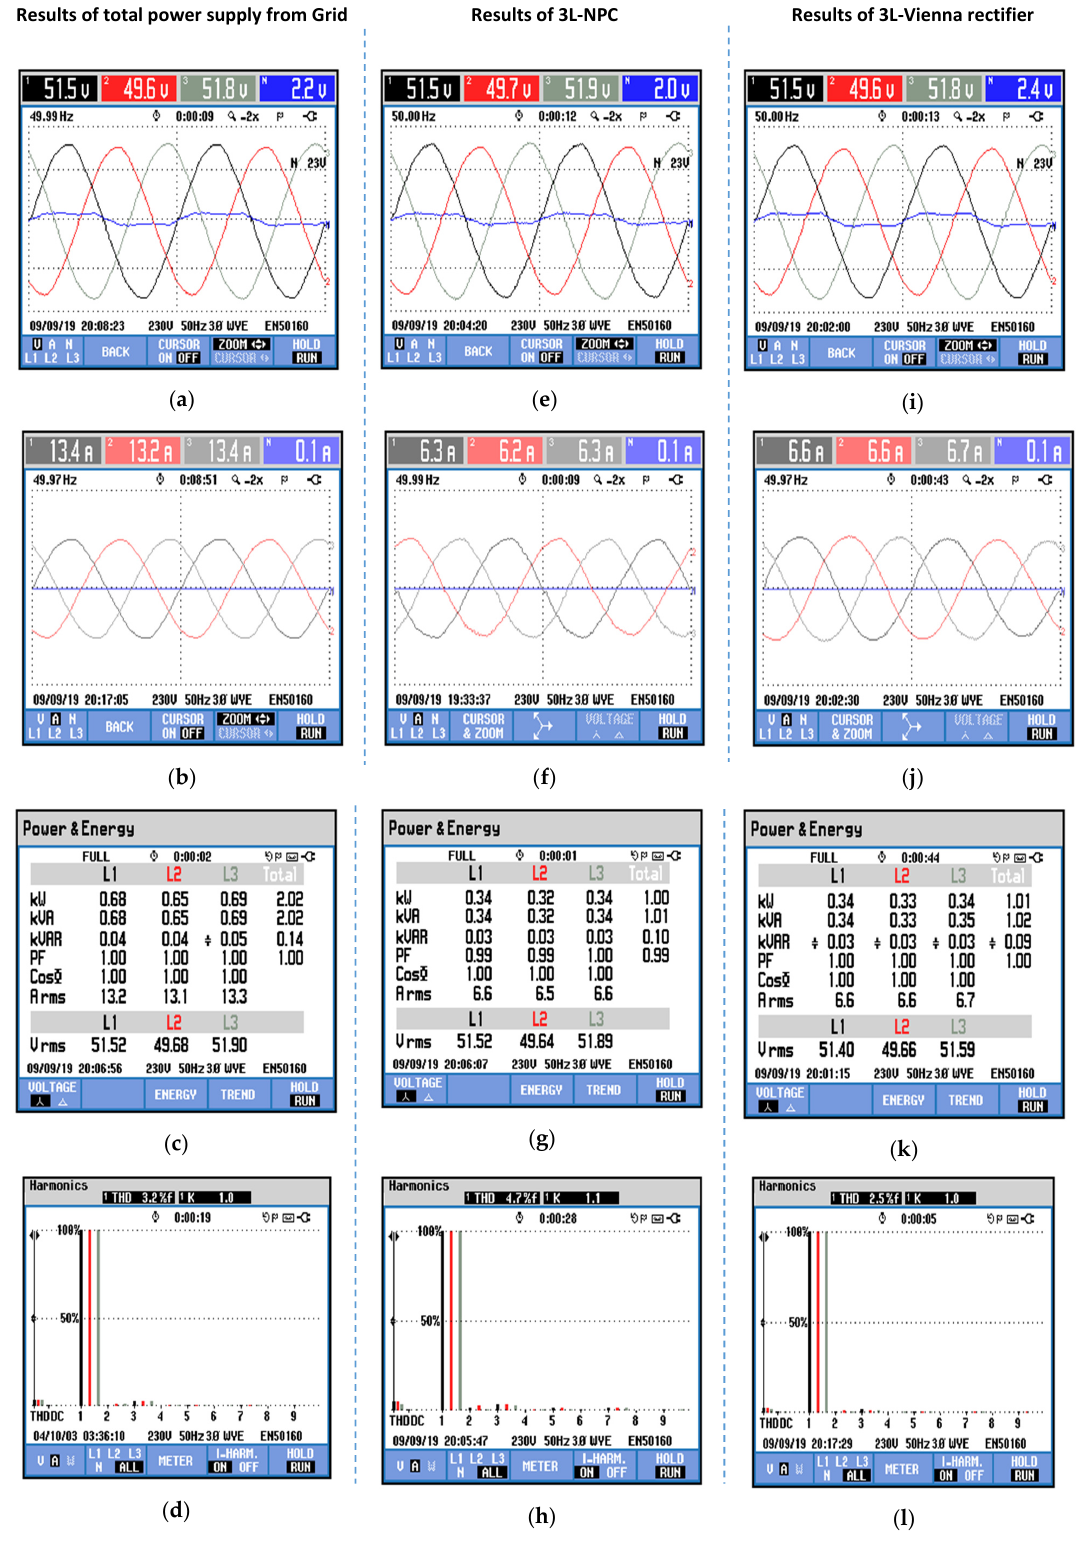
Figure 8. Experimental results of a 2-KW proposed hybrid converter.